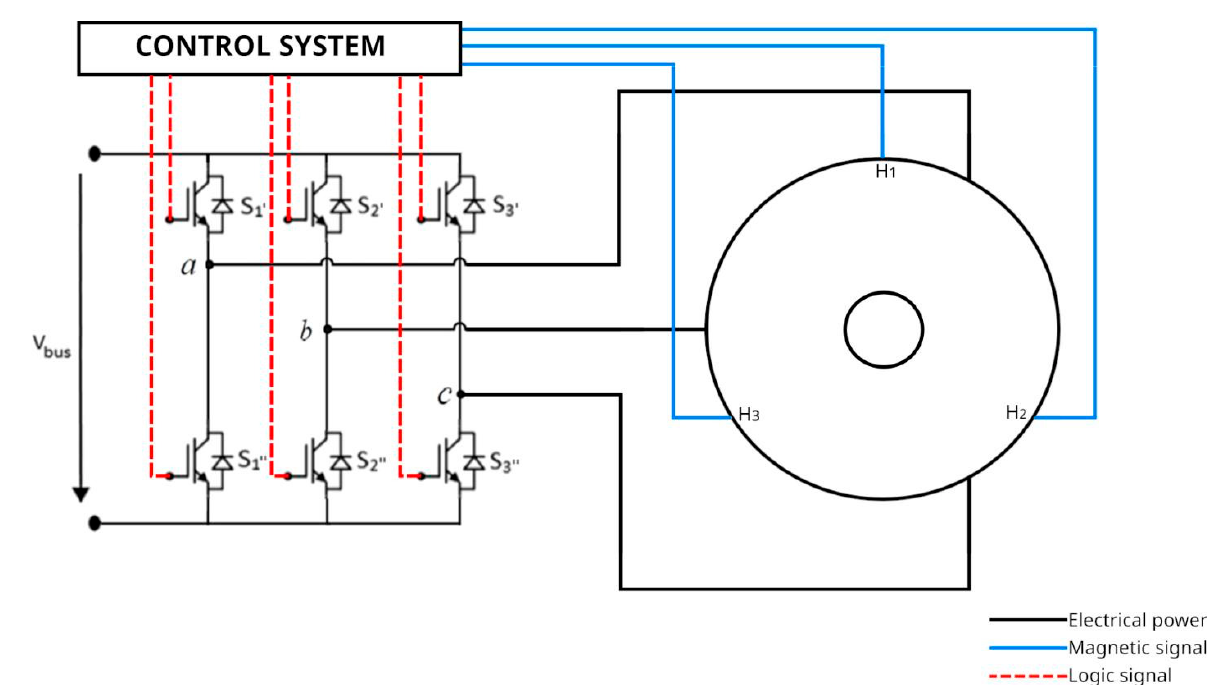
Figure 6. Motor system: electric motor, inverter, and control subsystems.